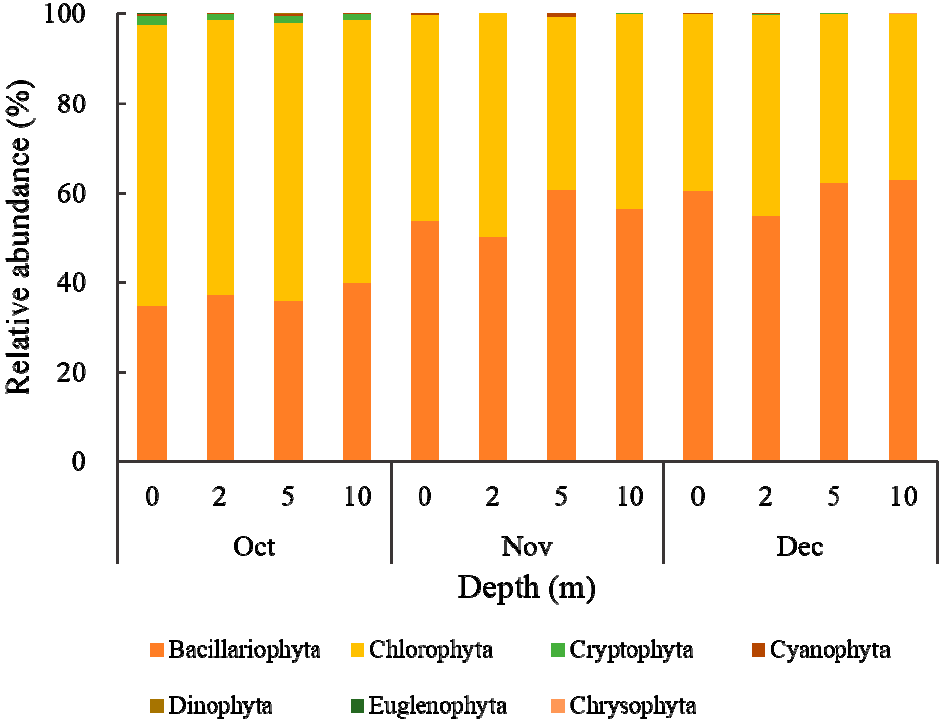
Figure 3. Phytoplankton community’s temporal-spatial variation at a phylum level from October to December in 2018.